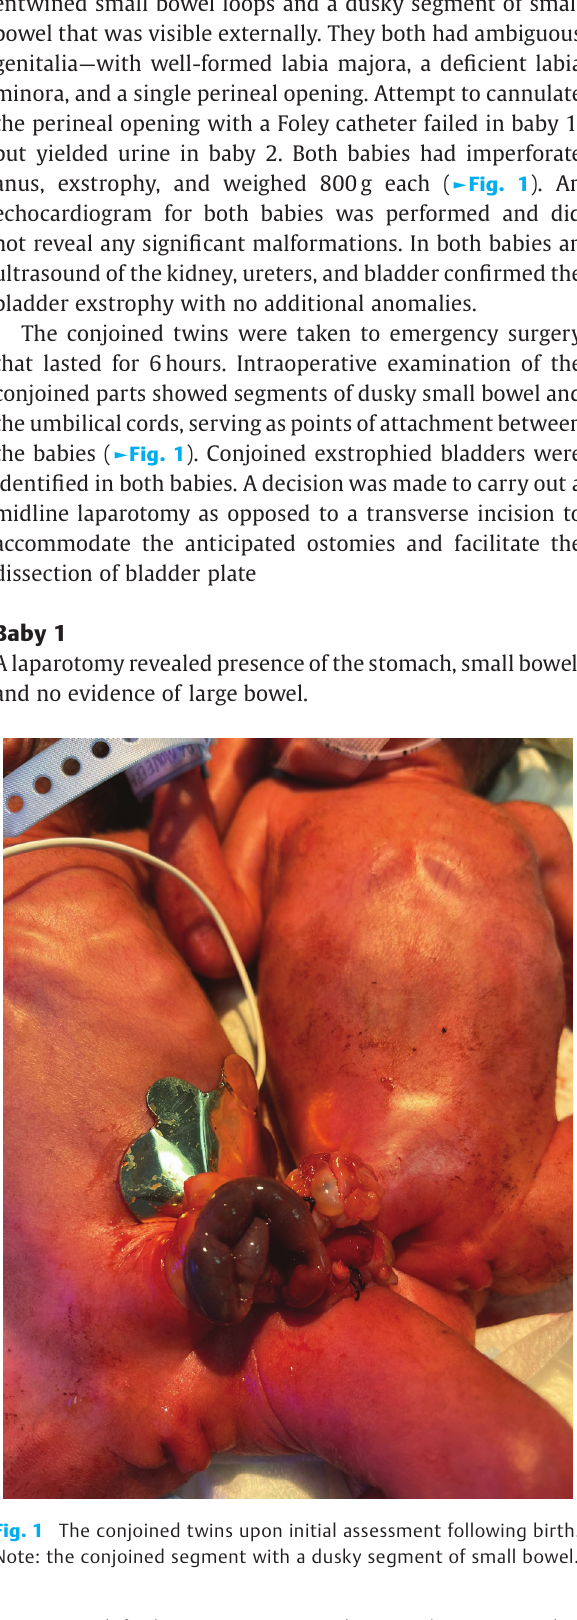
European Journal of Pediatric Surgery Reports Vol. 10 No. 1/2022 © 2022. The